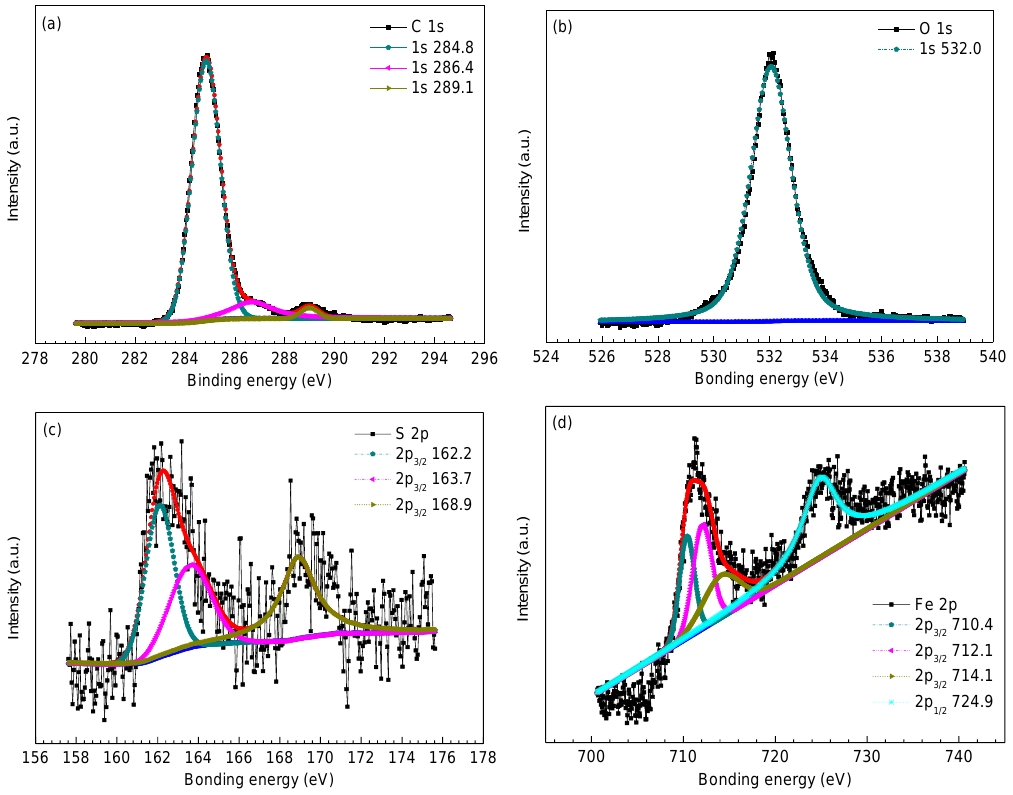
Figure 5. X-ray photoelectron spectroscopy (XPS) spectra and decomposition of peaks for different elements of the inner scale on P110 steel: ( a ) C 1s; ( b ) O 1s; ( c ) S 2p, and ( d ) Fe 2p.